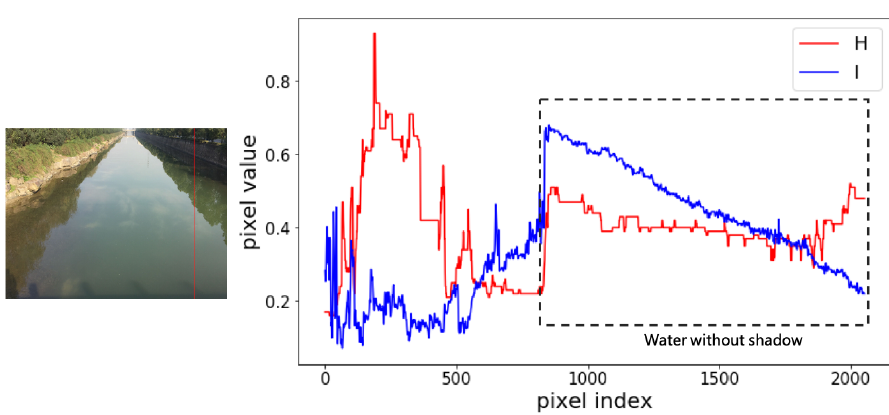
Figure 4. Pixel-wise intensity values and hue values in a column of river scene image.